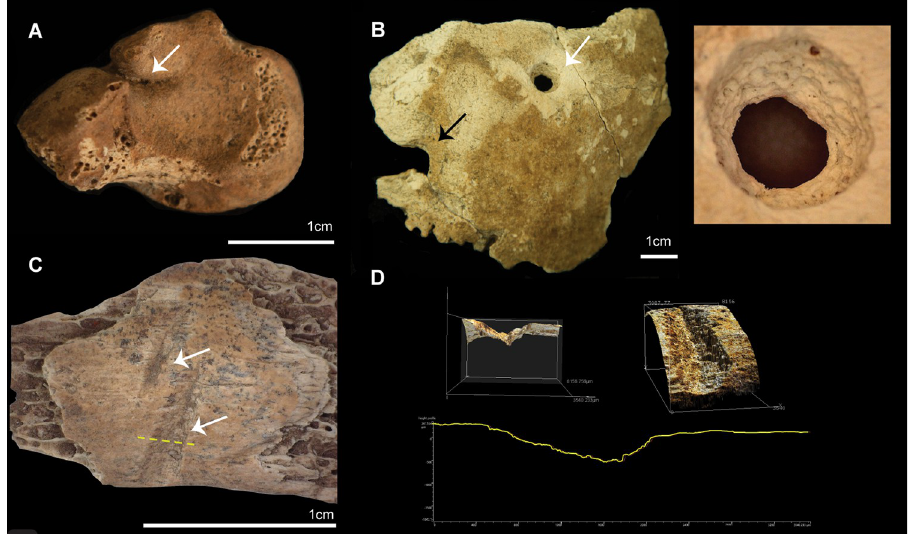
Fig 11. Pathologies and modifications in E16b. A) Left scaphoid with evidence of healed fracture; B) Left, fragment of right parietal with circular perforation and (white arrow) and incomplete outline of a second perforation (black arrow). Right, detail of circular perforation; C) Rib fragment with cutmarks. Yellow dotted line indicates the exact position of the profile represented in D. D) 3D Confocal images at 10x of colour data (top) and (bottom) profile of the cutmark analysed (yellow dotted line and white arrow in